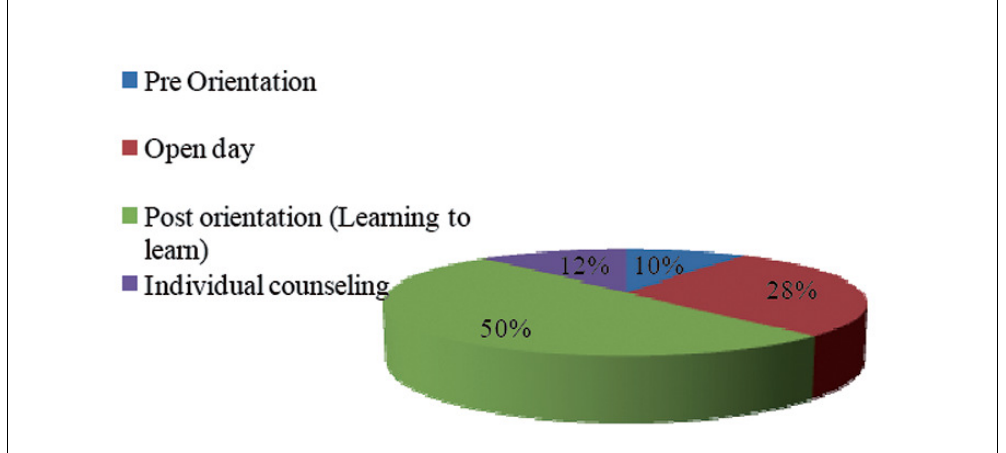
Figure 4 Mode of gaining in-depth knowledge on